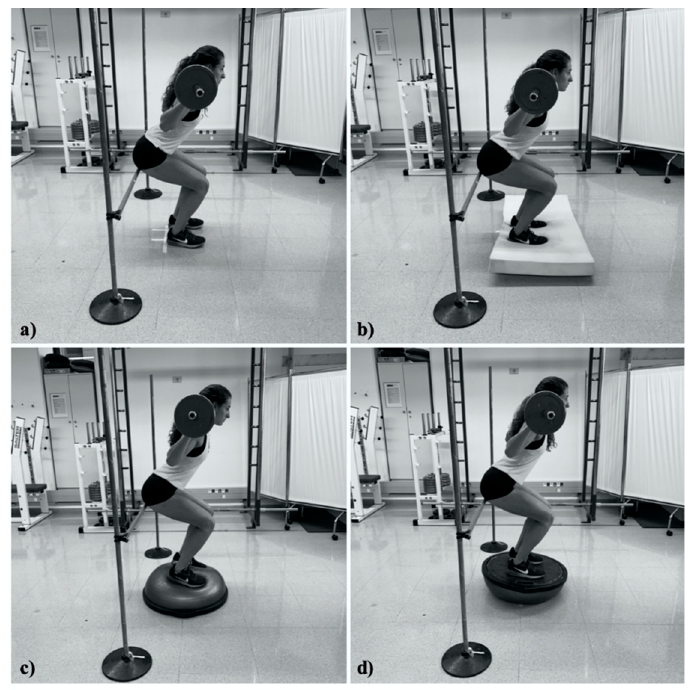
Figure 1. Exercise conditions: ( a ) half-squat floor, ( b ) half-squat foam, ( c ) half-squat BOSU-up, and ( d ) half-squat BOSU-down.